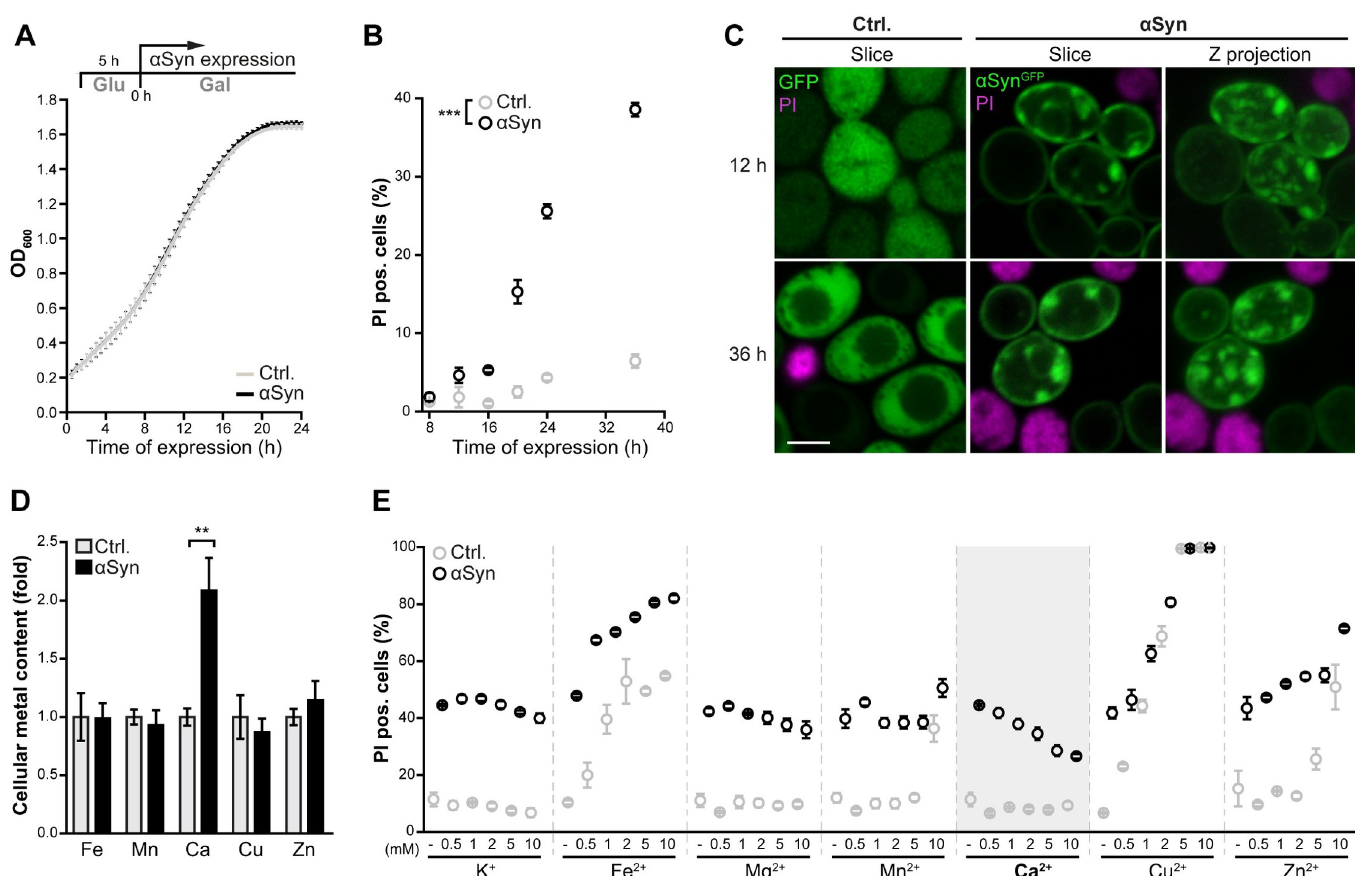
Fig 1. Administration of external Ca 2+ protects against α Syn proteotoxicity. ( A ) Growth kinetics of wild type cells expressing human α -synuclein ( α Syn) or harboring the corresponding vector control (Ctrl.) upon shift to galactose for promoter induction. Optical density (OD 600nm ) was determined every 30 min. Means ± s.e.m; n = 4. ( B ) Flow cytometric quantification of loss of membrane integrity via propidium iodide (PI) staining in cells expressing α Syn or harboring the vector control at indicated time points. Means ± s.e.m; n = 5. ( C ) Confocal micrographs of cells expressing GFP or α Syn GFP for 12 h and 36 h. Cells were counterstained with PI to visualize dead cells. Z- projections of three-dimensional stacks as well as a representative section are shown. Scale bar represents 2 μ m. ( D ) Total cellular metal content (Fe, Mn, Ca, Cu, Zn) of cells expressing α Syn for 24 h quantified via total reflection X-ray fluorescence (TXRF). Values were normalized to vector control cells per metal. Means ± s.e.m; n = 4. ( E ) Flow cytometric quantification of cell death via propidium iodide (PI) staining of cells expressing α Syn for 36 h or harboring the vector control. Growth medium was supplemented with indicated concentrations of K + , Fe 2+ , Mg 2+ , Mn 2+ , Ca 2+ , Cu 2+ or Zn 2+ . Means ± s.e.m; n = 4. �� p < 0.01 and ��� p < 0.001.